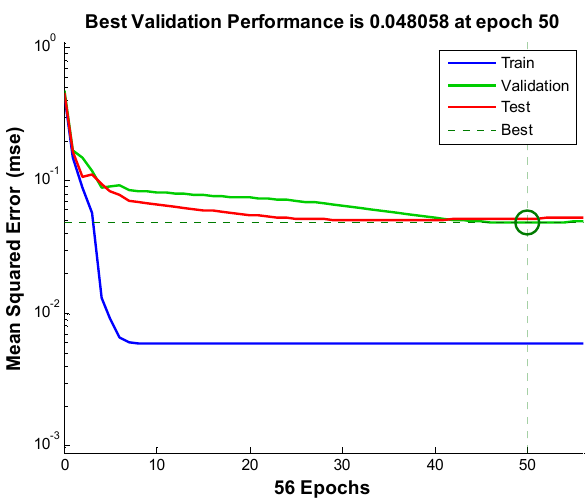
Figure 11. Neural network training error curve.